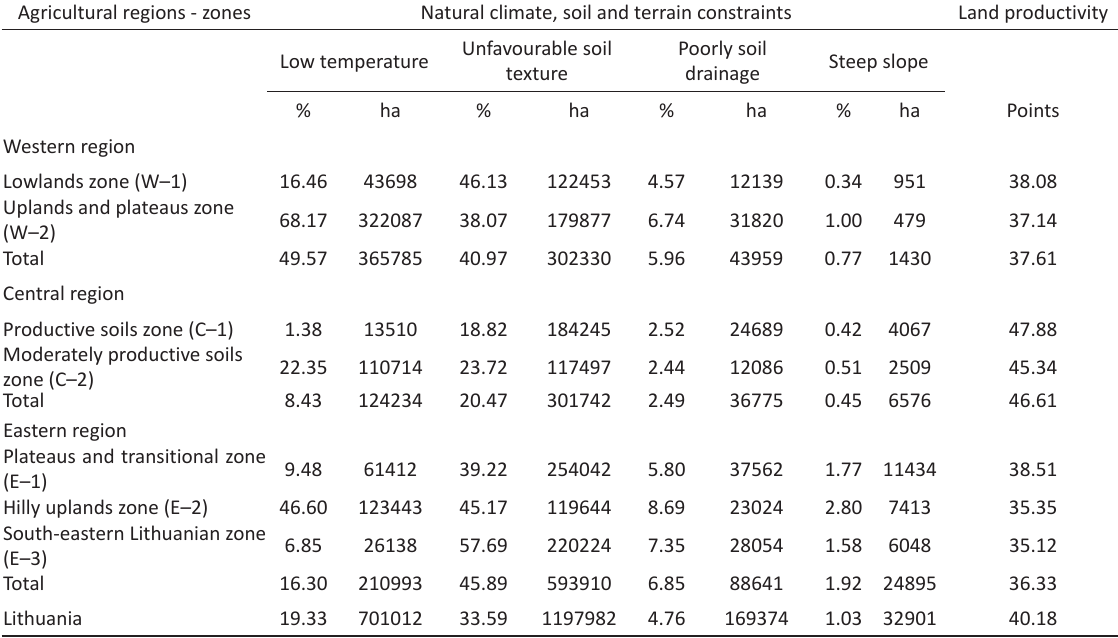
Table 2. Land productivity, area and share of area under natural climate, soil and terrain constraints at regional and national level Agricultural regions - zones Natural climate, soil and terrain